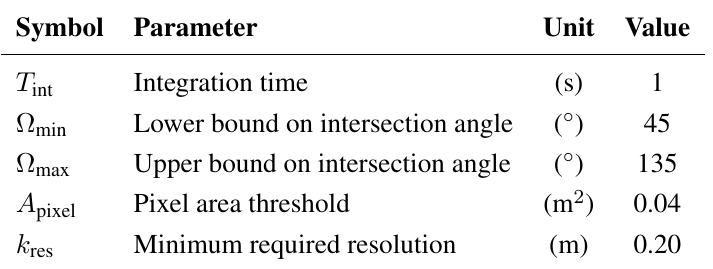
Table 6. Additional parameters for